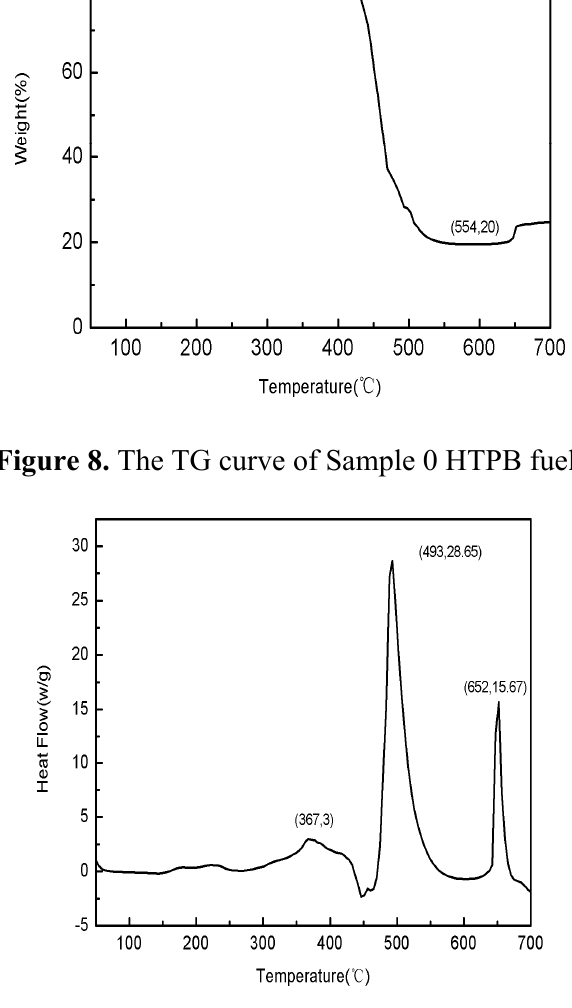
Figure 9. The DSC curve of Sample 0 HTPB